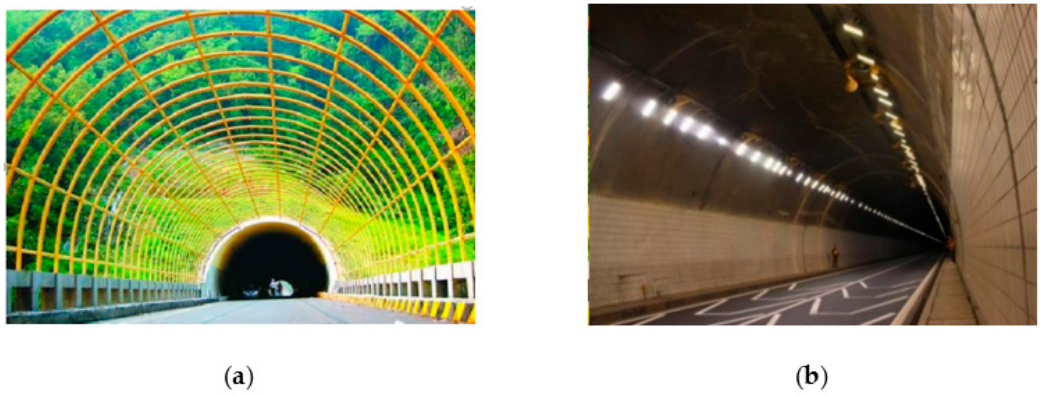
Figure 7. ( a ) Shading shed and ( b ) auxiliary strengthen lighting and reflective road markings.